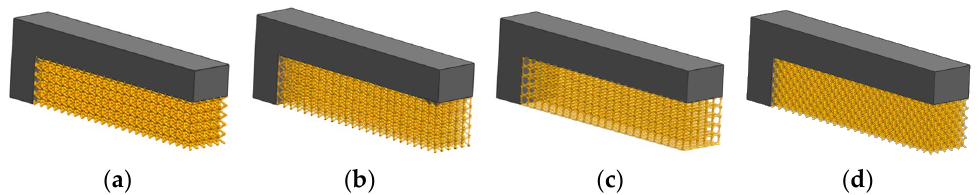
Figure 6. CAD model of cantilever test samples with various lattice supports. ( a ) BCC. ( b ) BCCZ. ( c ) Octahedroid. ( d ) Dodecahedron.